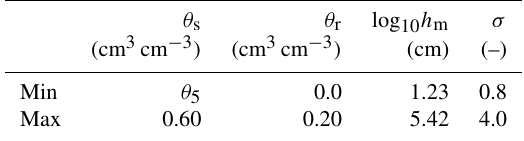
Table 1. Feasible range of the Kosugi parameters and θ 5 (which is θ measured at